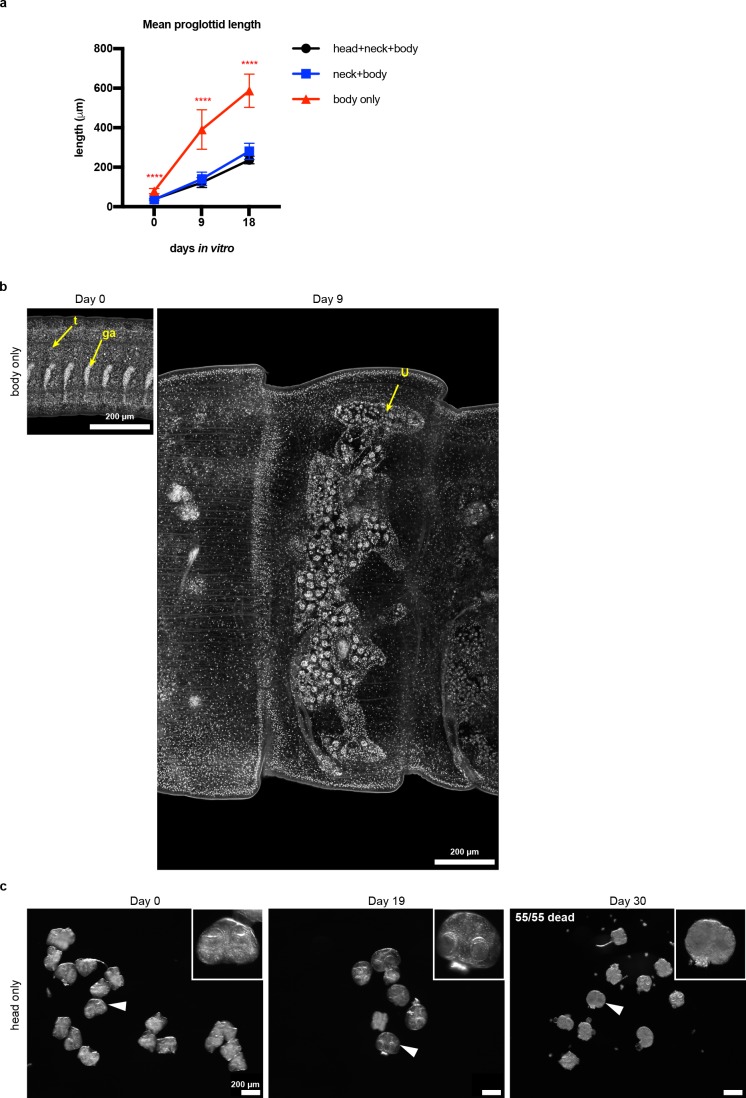
Phenotypic description of regeneration-incompetent tissues of H. diminuta.(a) Quantification of mean proglottid length (fragment length/# of proglottids). Mean proglottid length from body only fragments are significantly longer than mean proglottid length from either head+neck+body or neck+body fragments. Error bars = SD, N = 2–5, n = 7–21; one-way ANOVA with Tukey’s multiple comparison test done at each timepoint. (b), Confocal sections of the most mature proglottids from ‘body only’ fragments showing immature proglottids at day 0 and a gravid proglottid at day 9. t: testis, ga: genital anlagen, and u: uterus. (c), Micrographs of amputated heads over 30 days in vitro showing a failure to regenerate. White arrowheads point to examples shown in the insets.